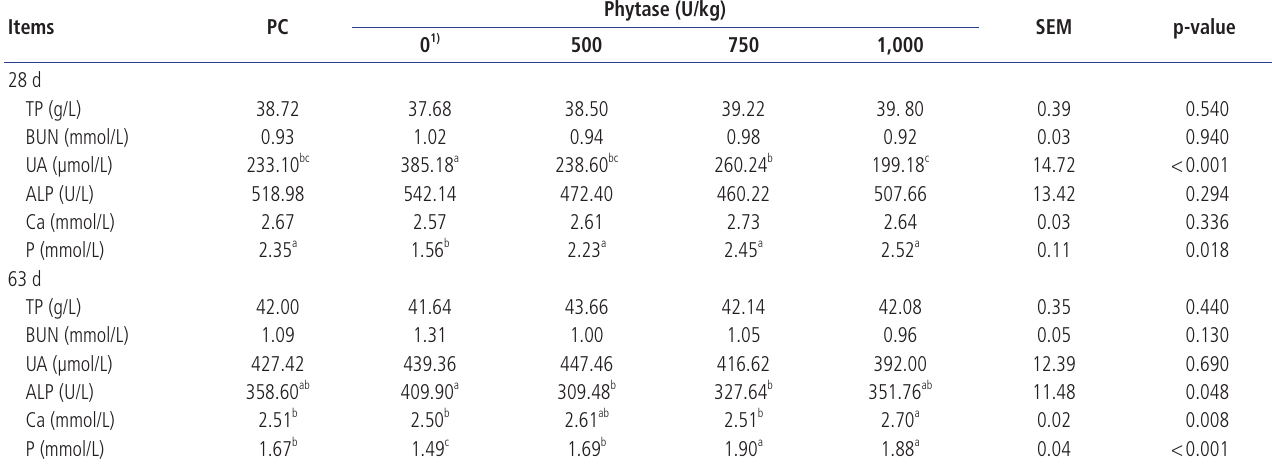
Table 4. Effect of phytase on plasma parameters in Youxian